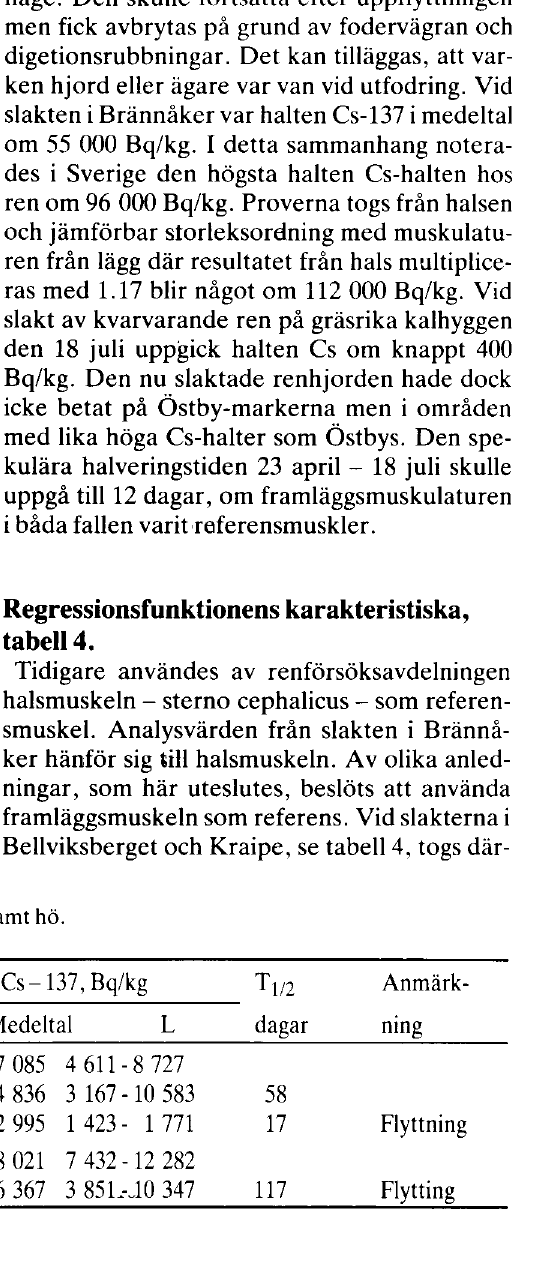
Tabell 3. Forandringar i Cs-halten april -